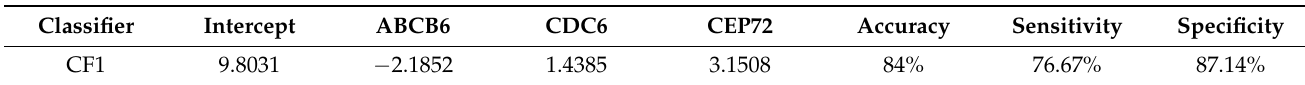
Table 19. GSE190680: Characteristics of the top-performing three-gene classifier CF1 for data of Alpha-E484K vs. Alpha.